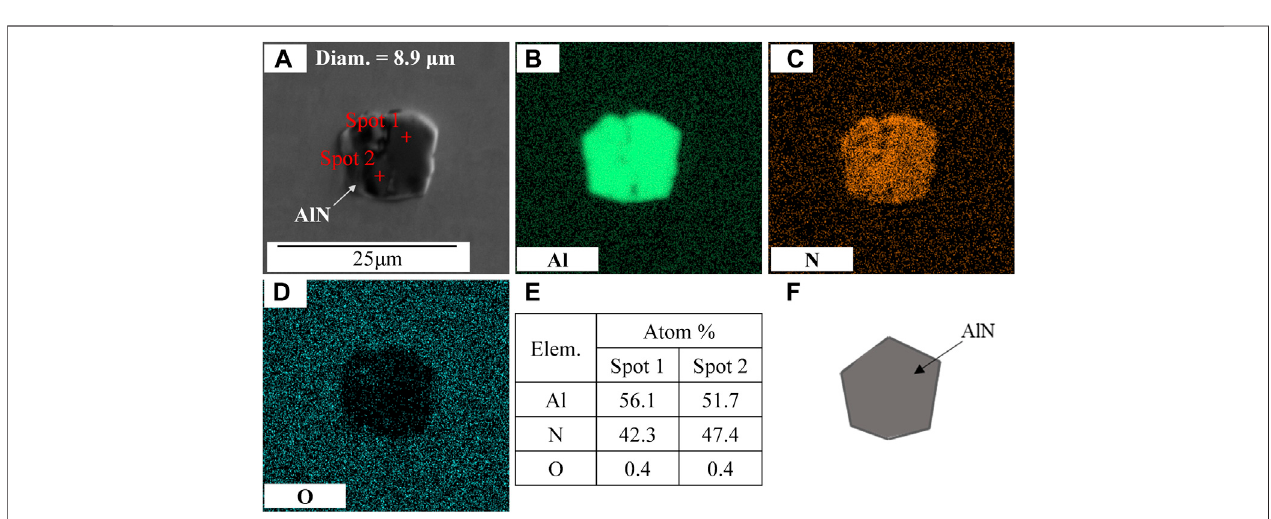
FIGURE 2 | Morphology and elemental mappings of AlN inclusion.